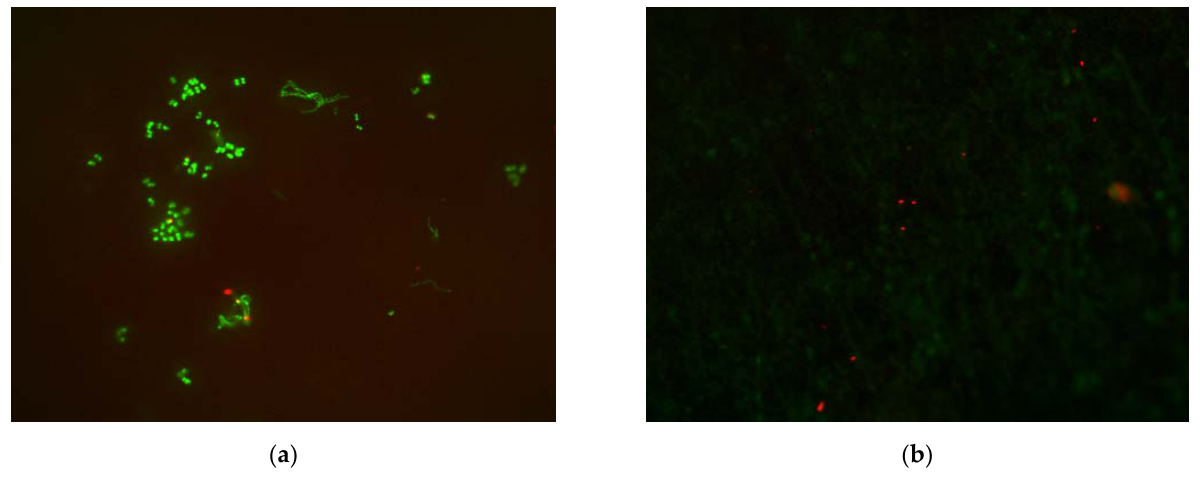
Figure 4. Comparison of representative superimposed fluorescence microscopic images (magnification 400 ‐ fold) of vital (green) and non ‐ vital (red) bacterial cells from a single participant: ( a ) ST accumulated many vital and a few non ‐ vital bacterial cells; ( b ) Antiadhesive A showed no vital but some non ‐ vital bacterial microorganisms.